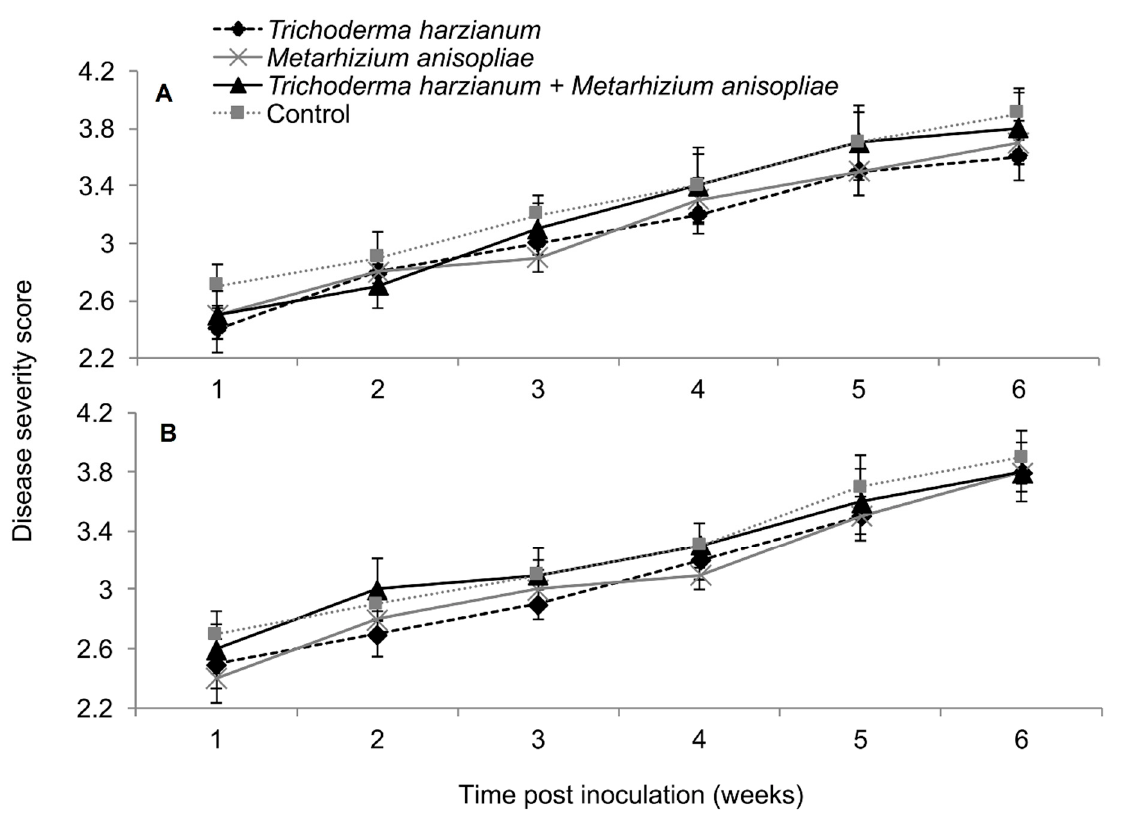
di ff erences in MLN severity were observed among the various treatments (Trial: F 3,27 = 1.004, P = 0.02; Trial 2: F 3,27 = 1.426, P = 0.251). Plants 2020 , 9 , x FOR PEER REVIEW